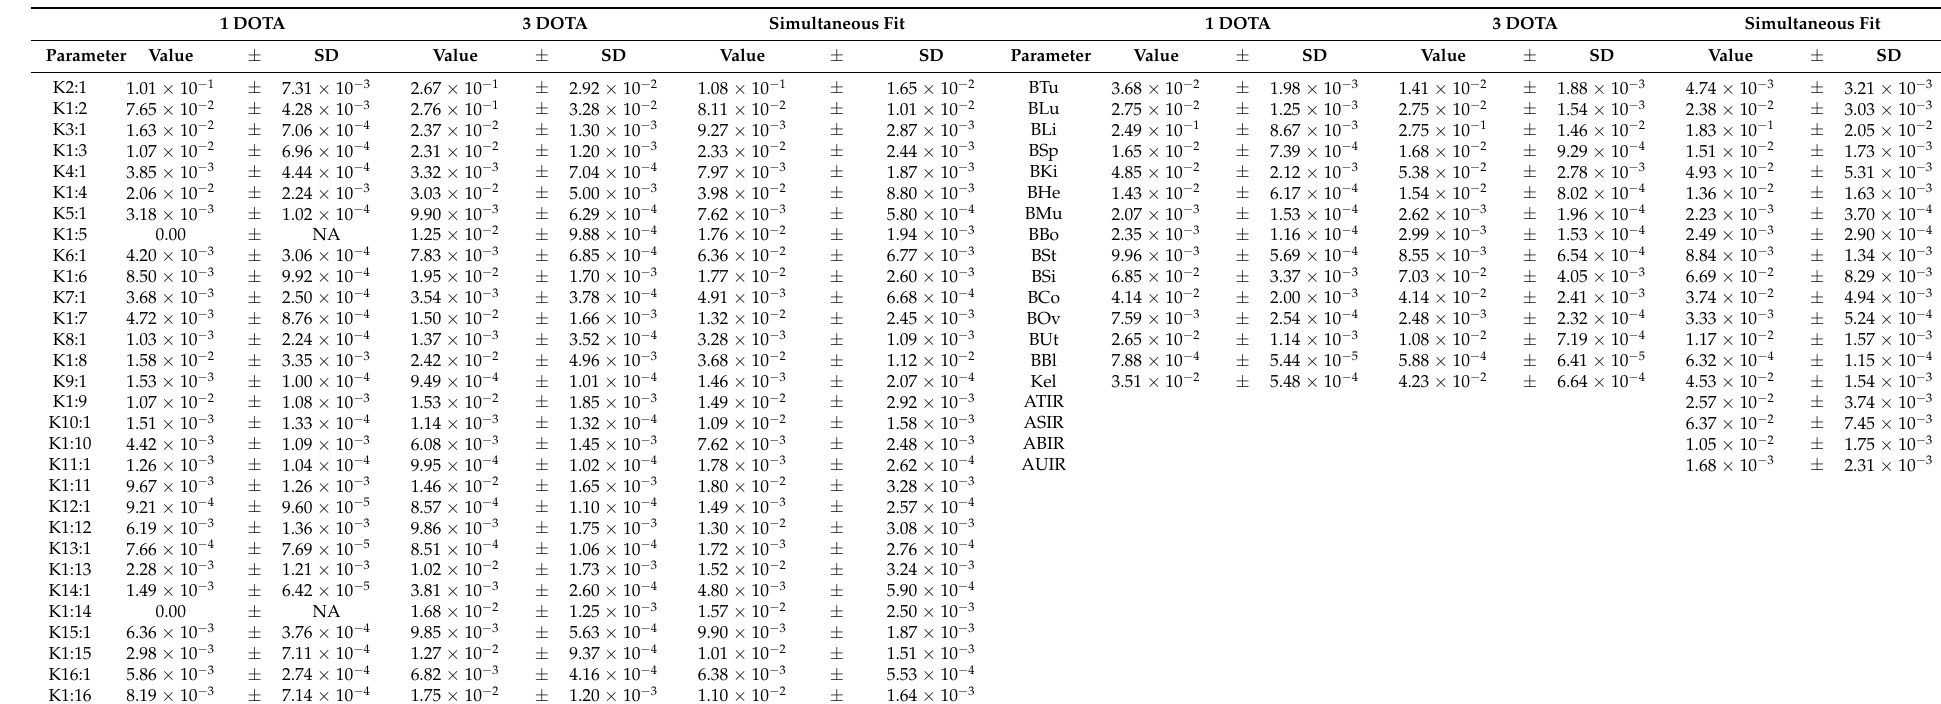
Table A1. Simultaneous fit